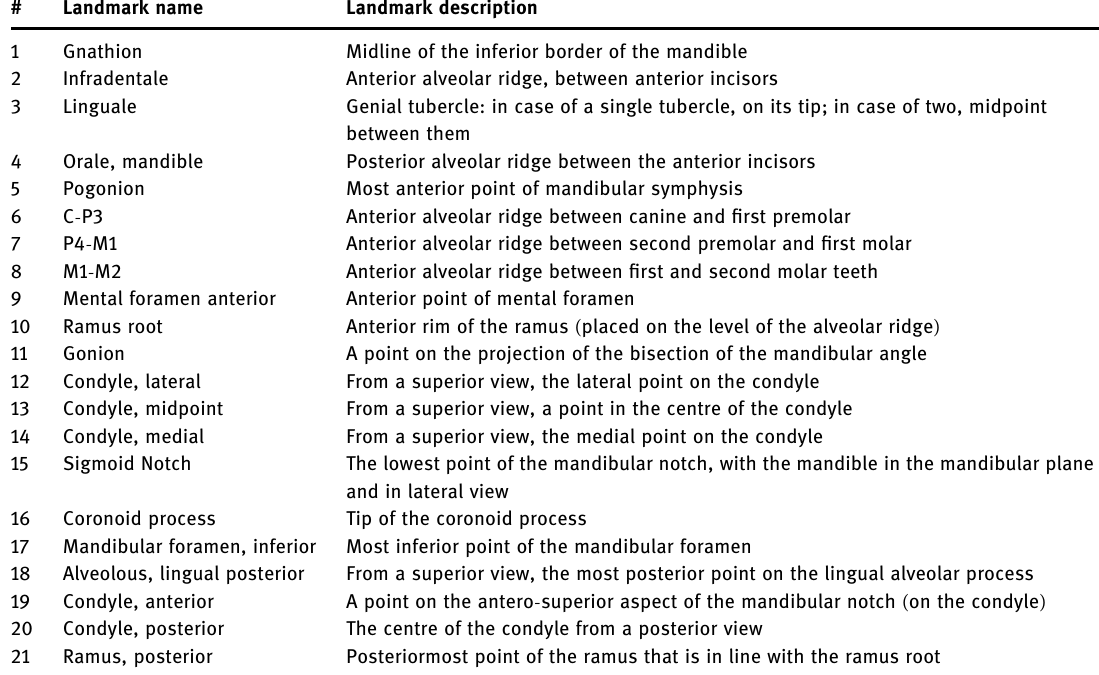
Table 2: Mandibular landmarks used in this